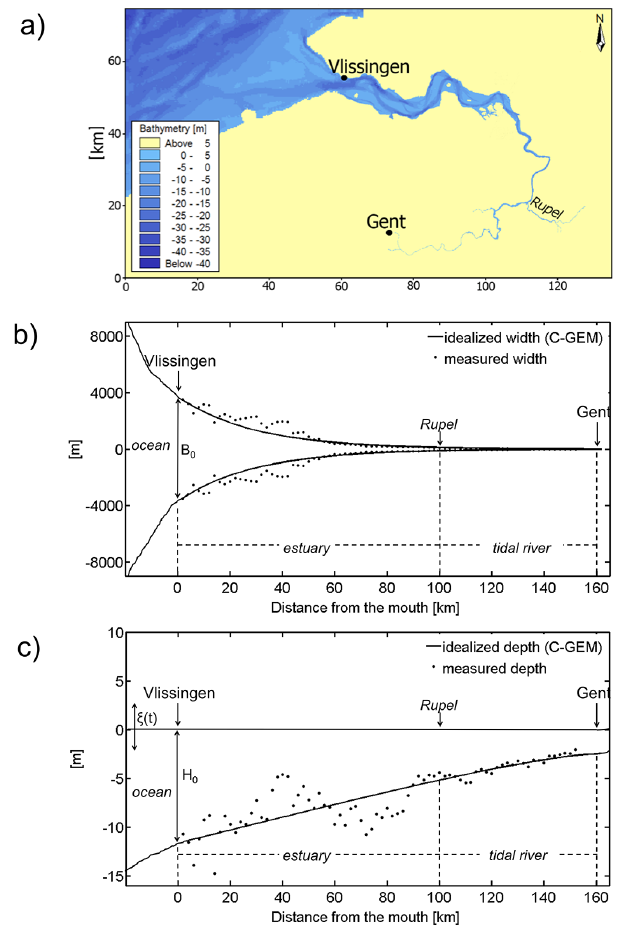
Figure 5. (a) Map of the Scheldt estuary obtained with a horizontal resolution of 80m × 80m for the channel up to the Belgian/Dutch border and 250m × 250m for the lower estuary. (b) and (c) : com- parison between observed width and depth (dots) and the idealized geometry supporting C-GEM (thick lines). The estuarine mouth is located at Vlissingen.